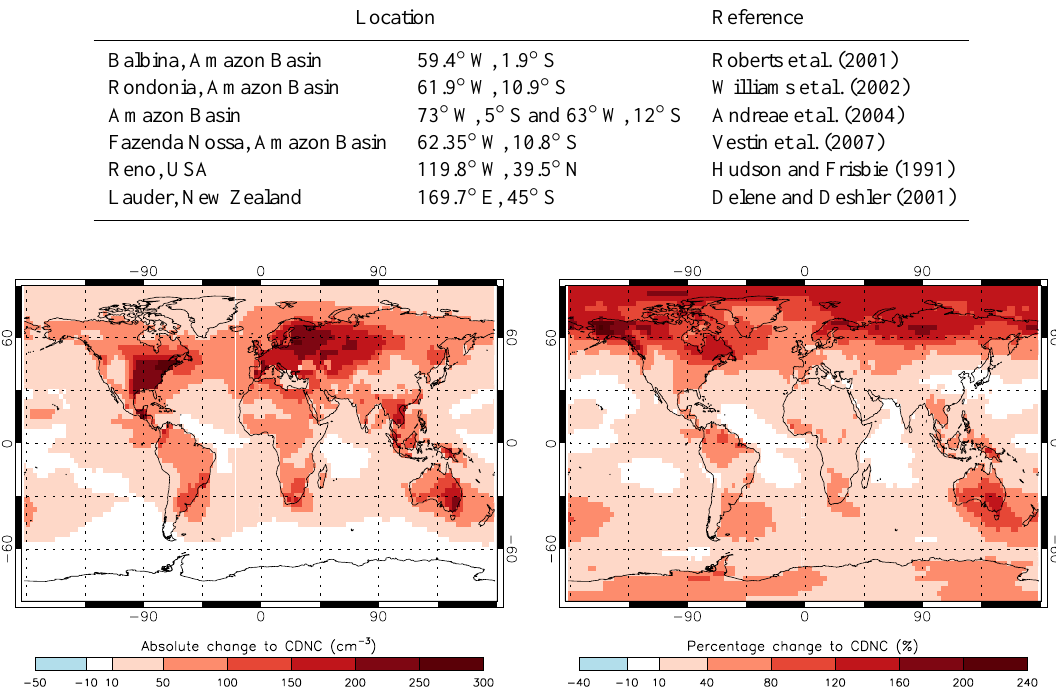
Fig. 6. Annual mean absolute (left) and percentage (right) change to CDNC due to biogenic SOA (monoterpenes only) when the Org1 nucleation mechanism is used (i.e. [CDNC] expt . 16 –[CDNC] expt . 15 )